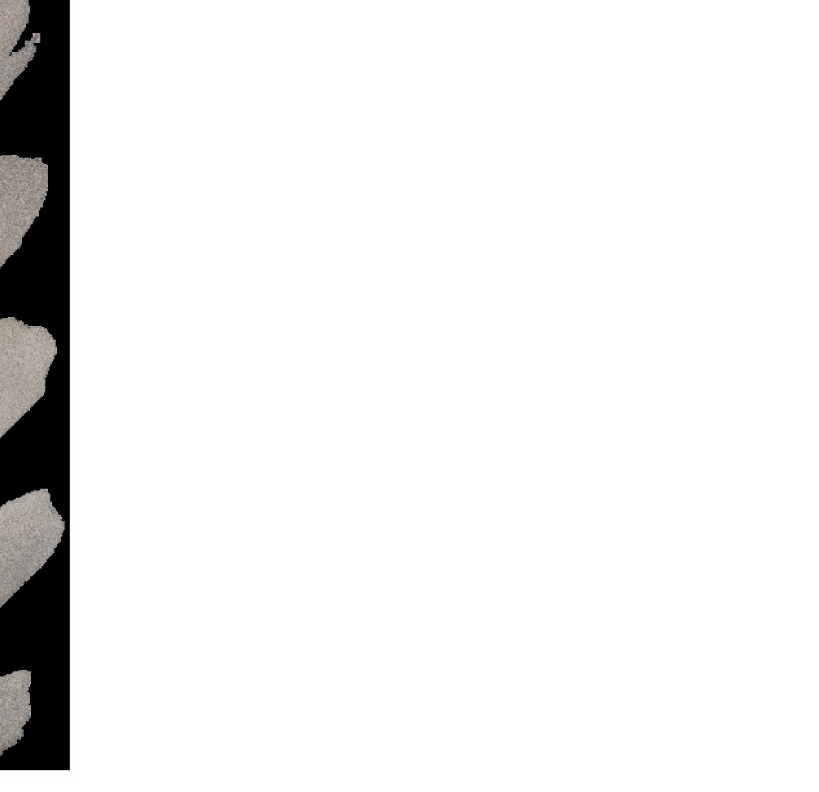
Figure 9. The FSW layer segmentation outcome based on the multi-stage adaptive binarization